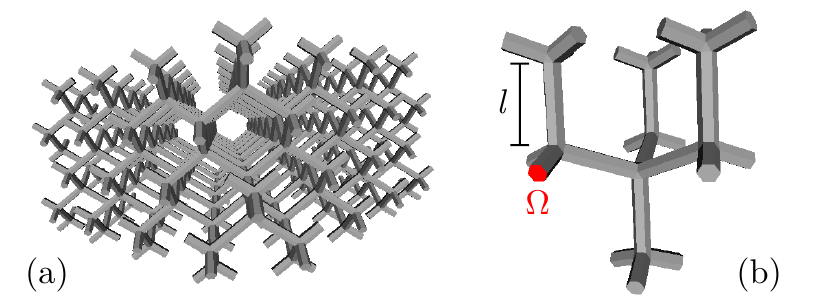
Figure 1. ( a ) Diamond lattice made of interconnected rods. A small part of the structure is detailed in ( b